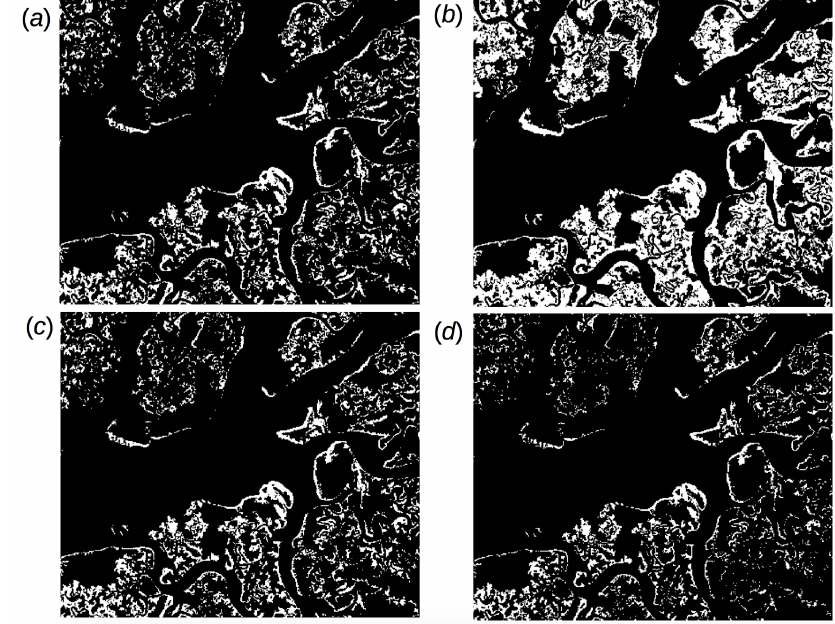
Figure 3. Excerpts of ( a ) the WSVM map, ( b ) the OCSVM map, ( c ) the SVM map, and ( d ) the BSVM map. Top-left corner (332427,1536155) bottom-right (343366,1529391) EPSG: